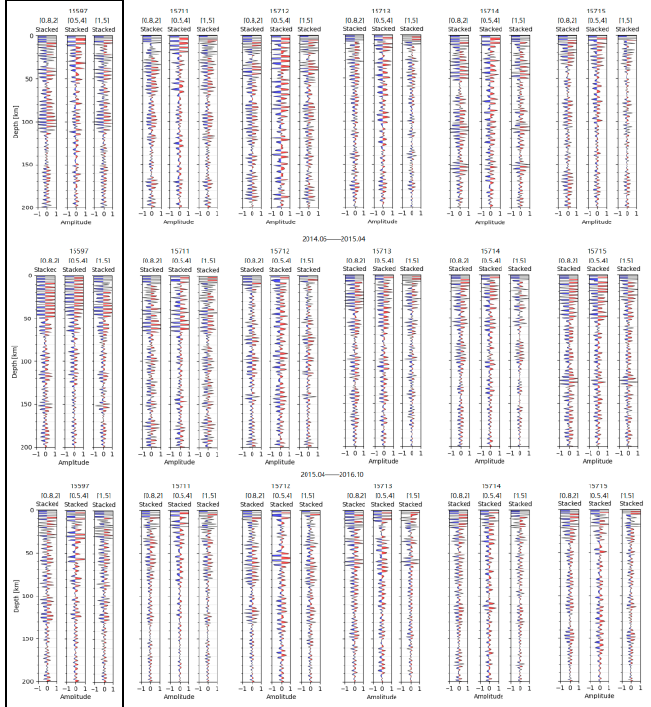
Figure 13. L7 (15670, 15675, 15681, 15688 and 15693 from left to right) reflects the depth results of